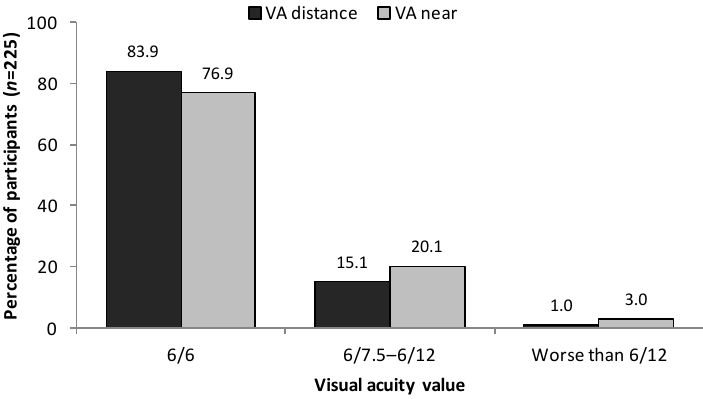
Figure 2. Grade 4 and 5 learners’ scores obtained